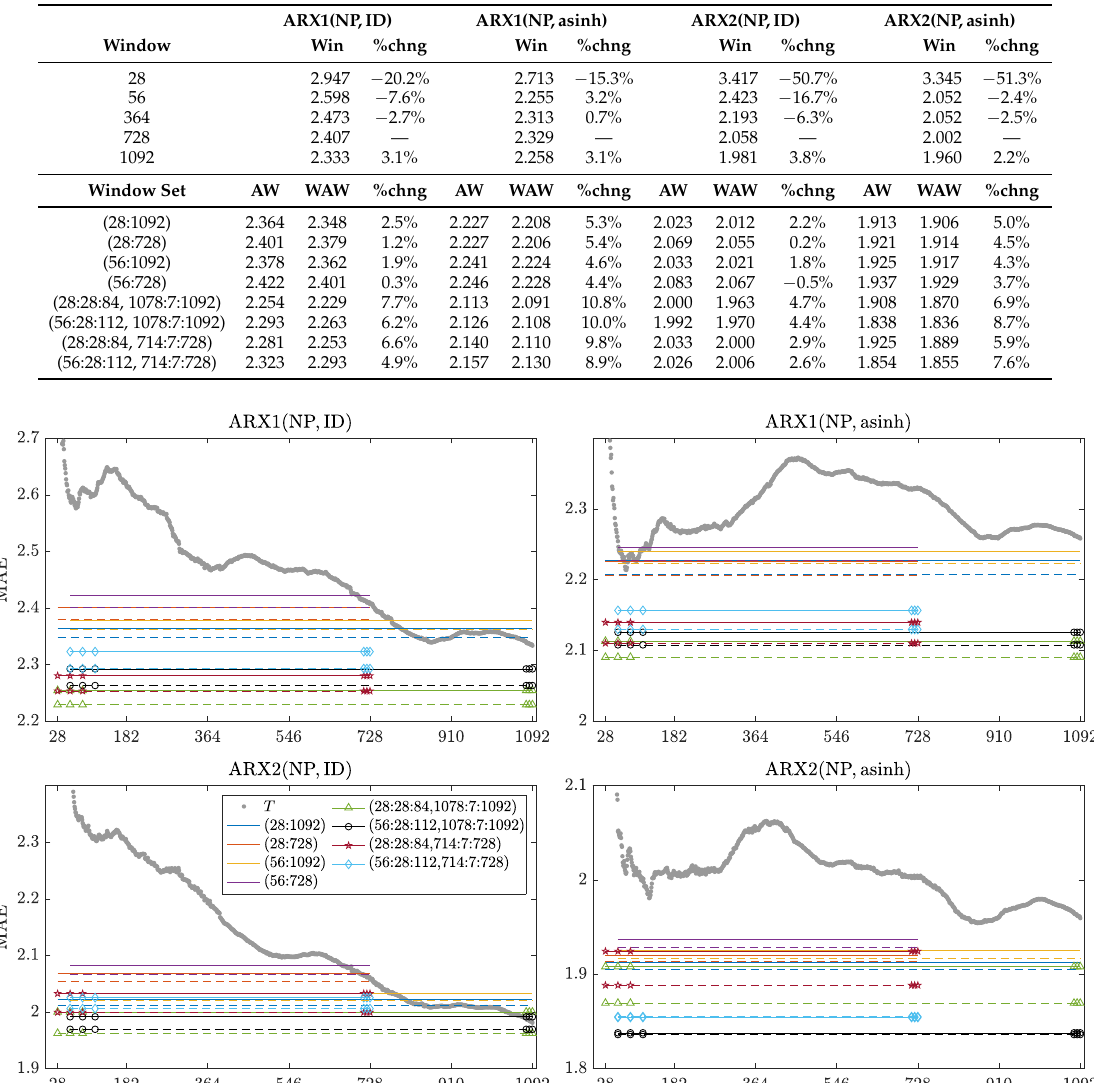
Table 1. Mean absolute errors (MAE) of the ARX1 and ARX2 models fitted to ID - or asinh -transformed Nord Pool (NP) data for selected windows ( T ) and window sets ( T ). Relative improvements (%chng) of the Win ( T ) and WAW ( T ) forecasts with respect to Win (728) are also reported.